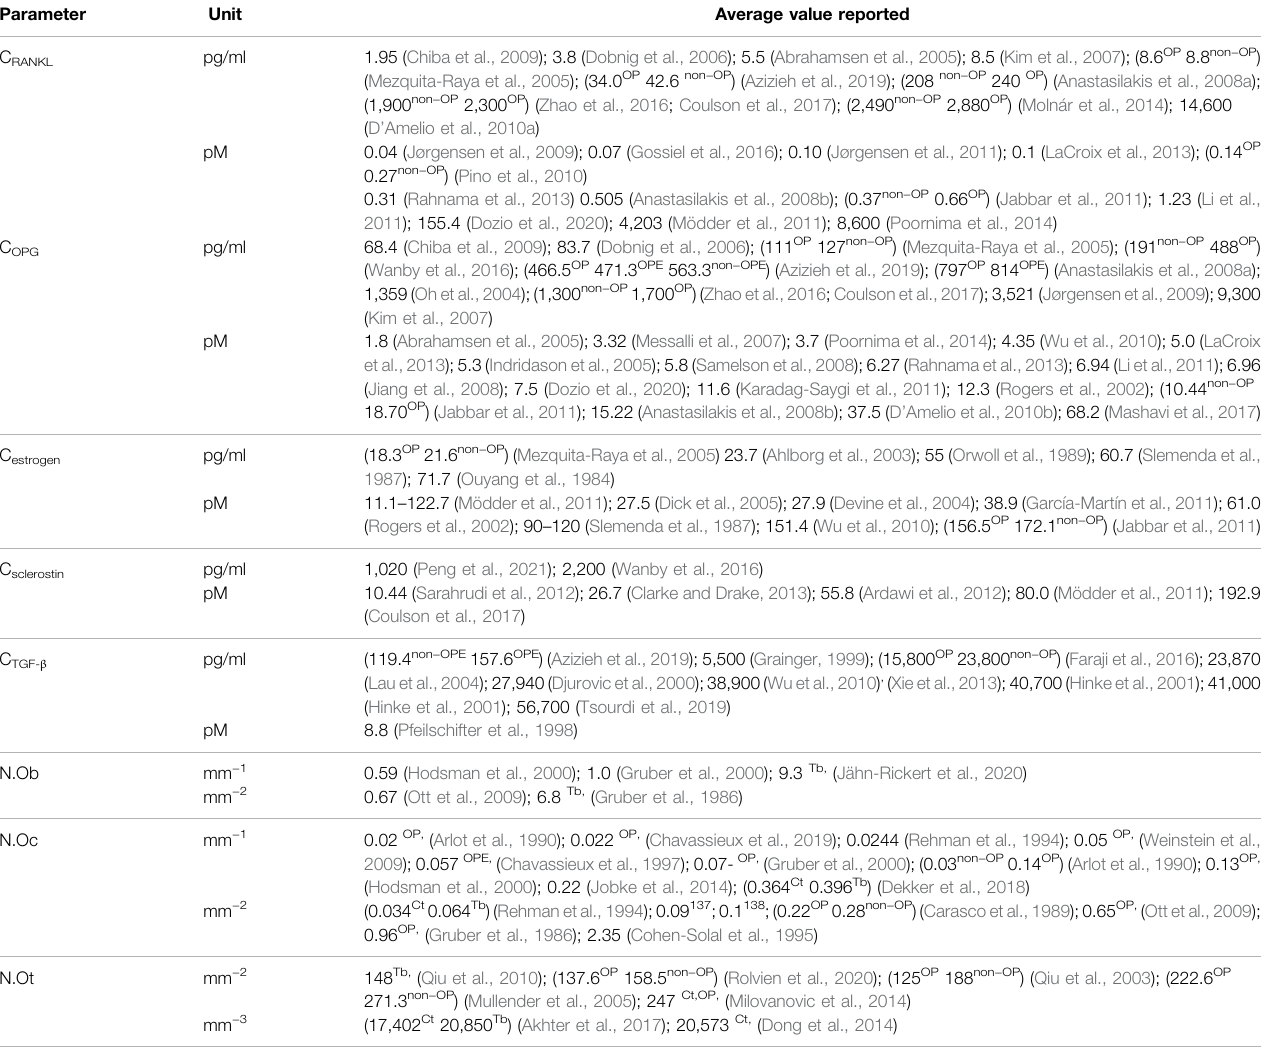
TABLE 3 | Average values reported in the literature for bone cell numbers and cytokine concentrations in postmenopausal women, including all anatomical sites, imaging techniques and study designs. Parameter Unit Average value